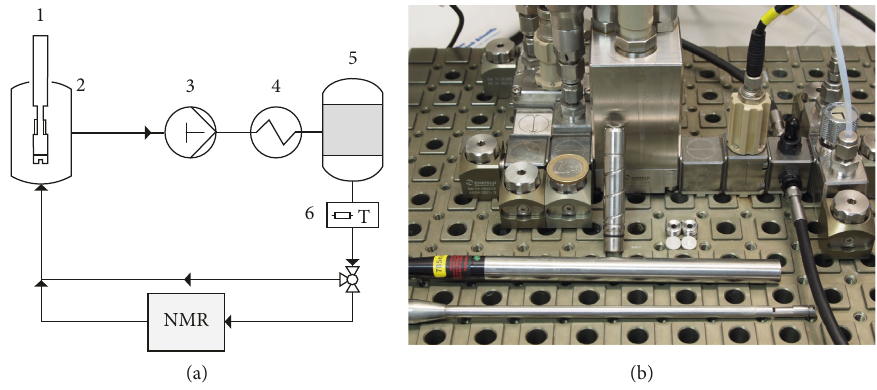
Figure 1: (a) Process flow-chart of the microreaction assembly: 1, Raman and NIR probe; 2, storage vessel containing the majority of the reaction mixture; 3, piston pump; 4, heat exchanger; 5, cartridge reactor; 6, temperature sensor; and then a compact 1 H NMR spectrometer is located in a bypass. (b) Picture of the microreaction platform (from left to right): inlet module, heat exchanger, cartridge reactor, T-sensor, optical flow cell, and outlet module. Raman probe and transflection NIR immersion probe (front).